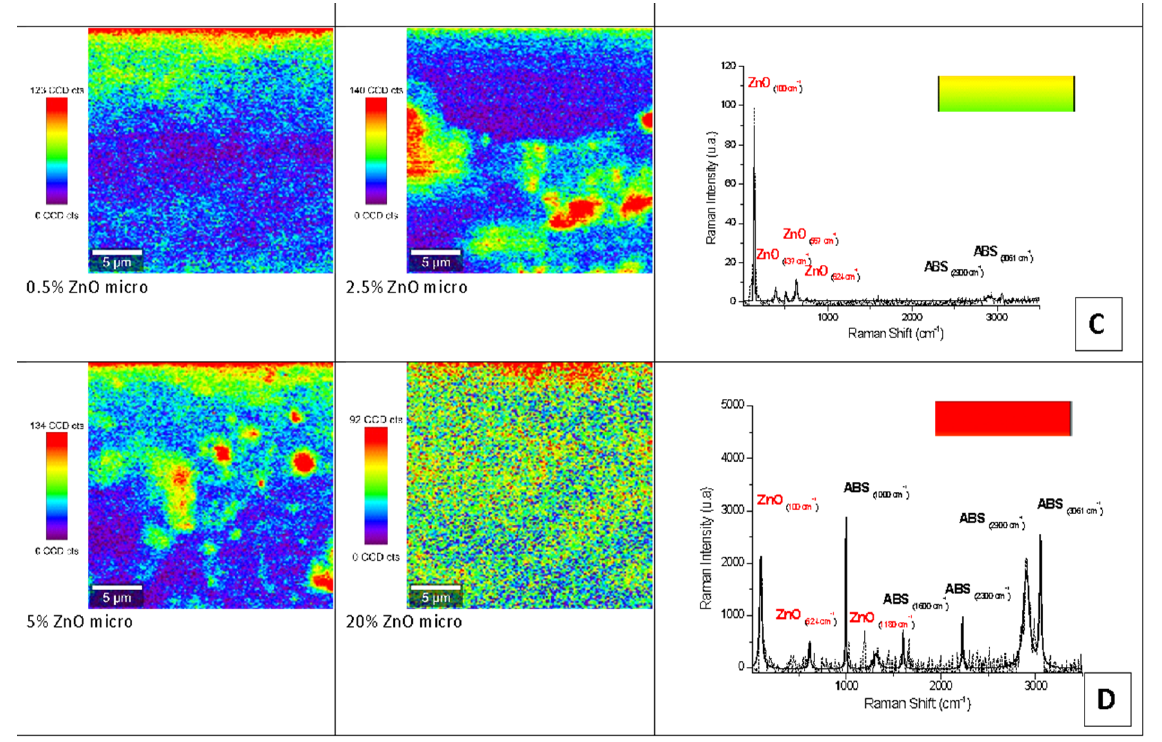
Figure 8. Raman mapping and spectra of micro-ZnO-ABS printed composite materials. ( C ) Example of a Raman spectrum corresponding to yellow-green color regions in the maps; ( D ) example of Raman spectrum corresponding to red color regions in the maps.